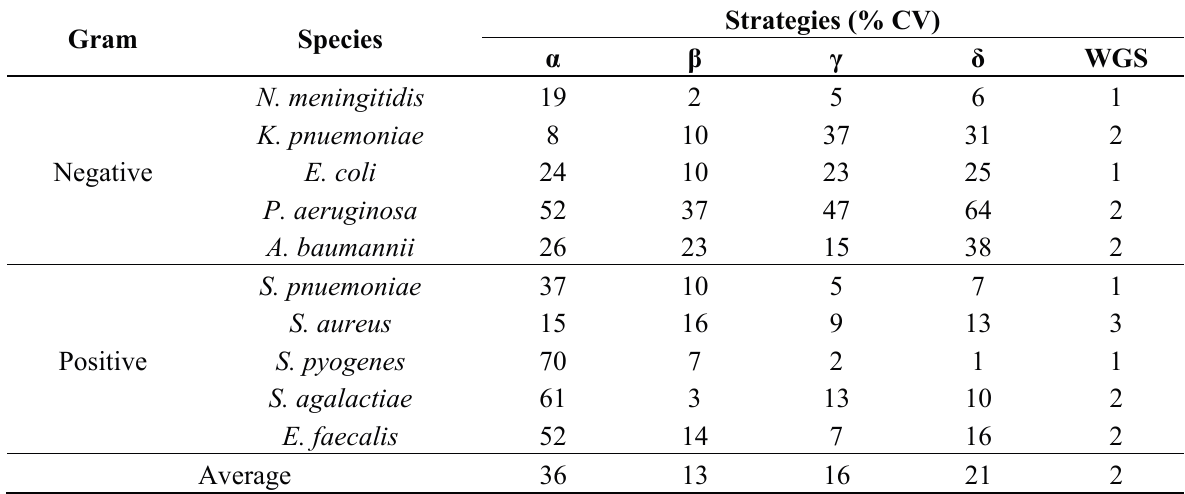
Table 1. The % coefficient of varation (CV) of the 5 different strategies in targeting the 10 species present in the metagenomic control material (MCM), in order of abundance high to low for Gram negative and Gram positive